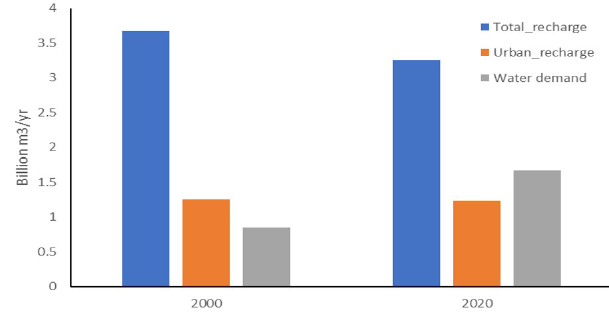
Figure 3. Comparison of simulated recharge over the entire aquifer domain and over the Lagos-urban with water demand for the years 2000 and